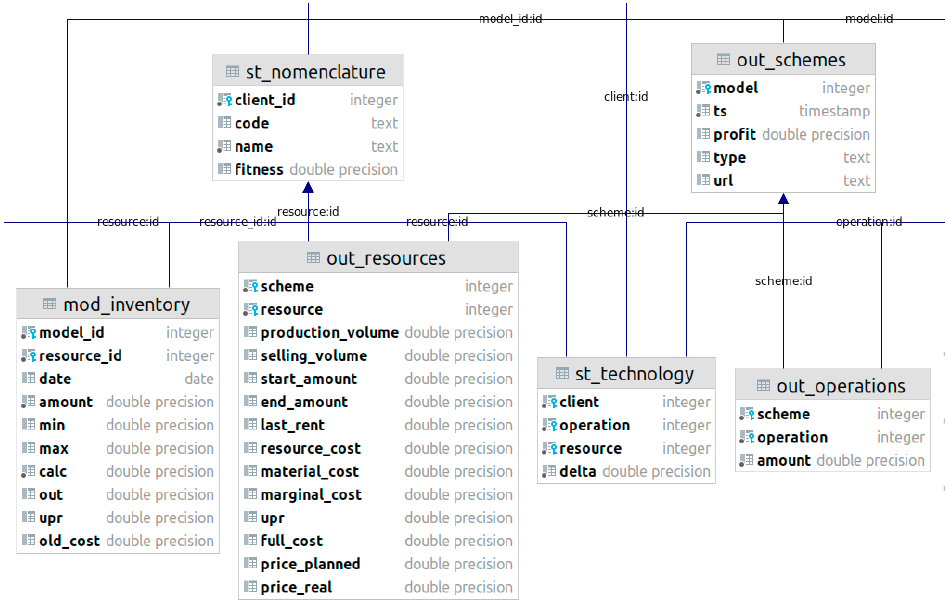
Figure 1. Information system relational database schema (fragment).